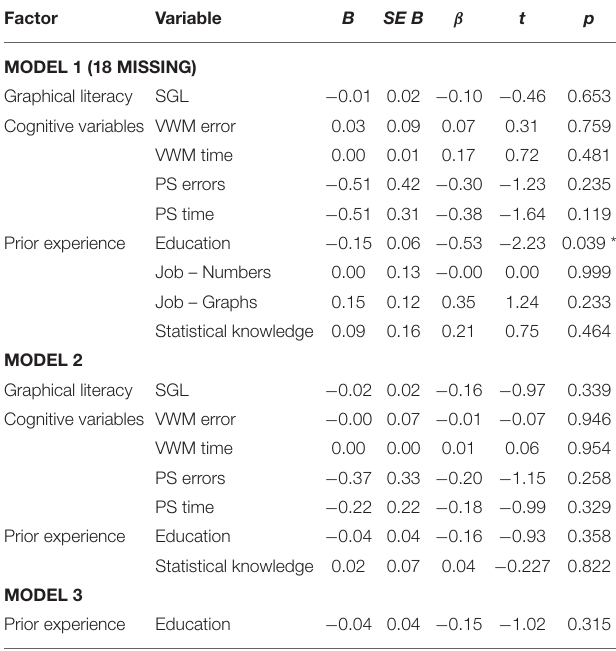
TABLE 2 | Study 2: multiple regression models to predict the errors in the expert cluster.